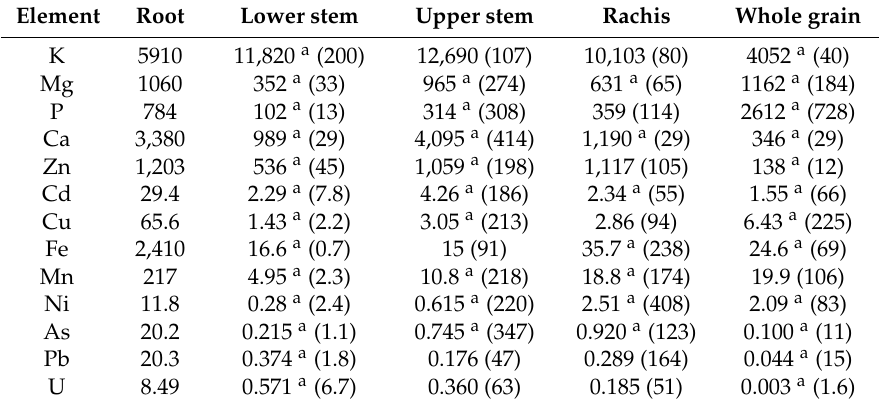
Figure 1. Variation in concentrations of minerals from the root (R; 100%) via the lower part (L; 12 cm) of the mature wheat stem to upper stem (U), rachis (R), and grain (G). Values are arithmetic means for sets of minerals with similar modes of passage (refer to Table 1). Table 1. Up ‐ and down ‐ regulated mineral concentrations (mg kg − 1 DW) across the mature plants of wheat cv. Asano grown on the high ‐ contaminated uranium gradient soil A. ( ), quotients calculated from mineral concentrations of the actual to the preceding column expressed in percent.